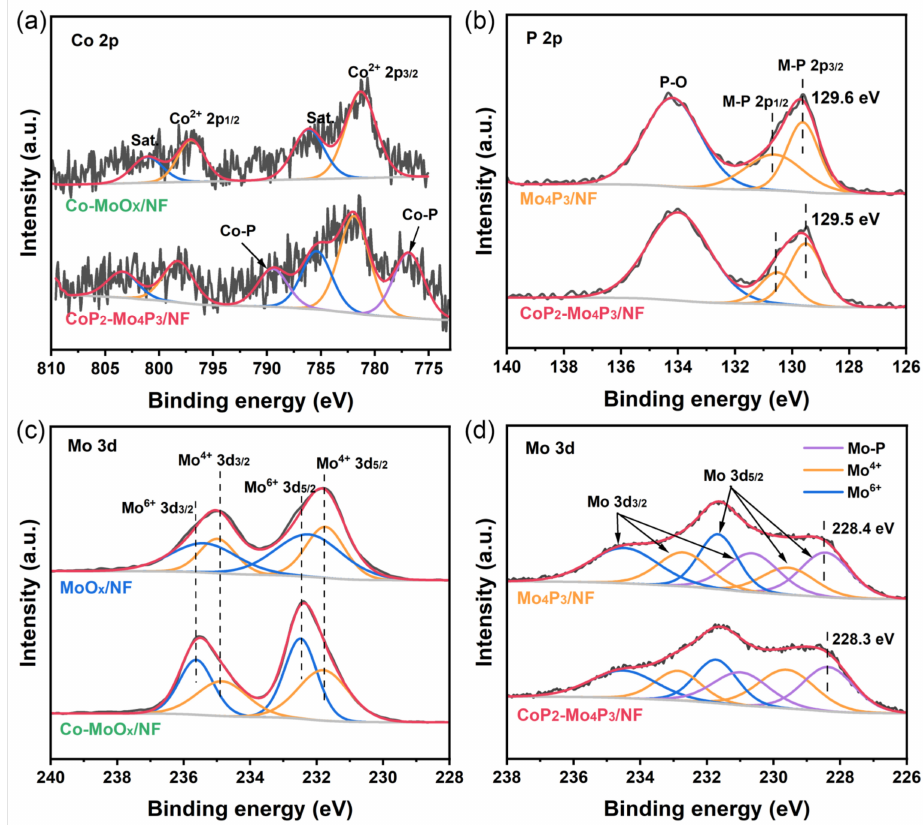
Figure 2. ( a ) Co 2p XPS spectra of Co-MoO x /NF and CoP 2 -Mo 4 P 3 /NF, ( b ) P 2p XPS spectra of Mo 4 P 3 /NF and CoP 2 -Mo 4 P 3 /NF, ( c ) Mo 3d XPS spectra of MoO x /NF and Co-MoO x /NF, ( d ) Mo 3d XPS spectra of Mo 4 P 3 /NF and CoP 2 -Mo 4 P 3